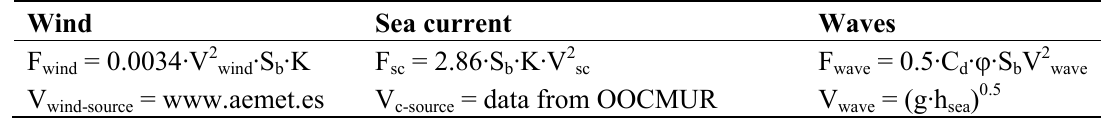
Table 2. Considered oceanographic models.